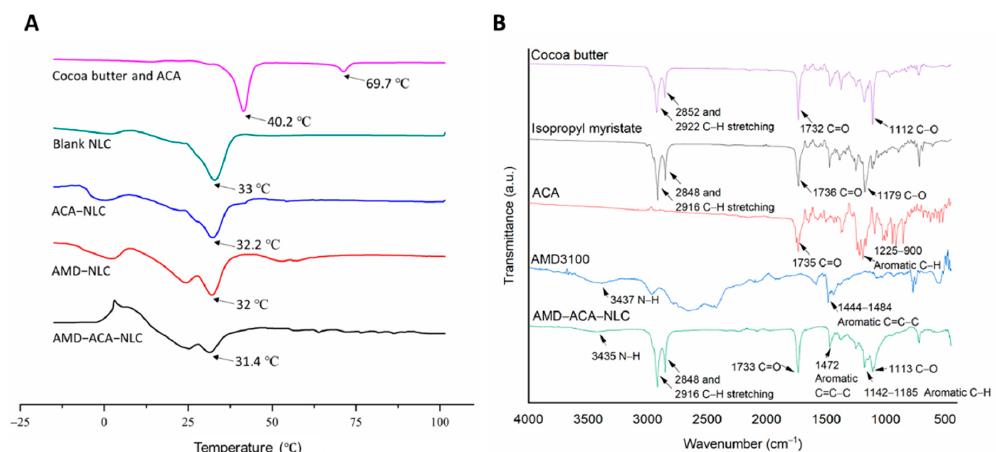
Figure 2. Differential Scanning Calorimetry (DSC) thermograms and Fourier-Transform Infrared Spectroscopy (FTIR) spectrum of samples. ( A ) Thermograms of cocoa butter–ACA physical melt, blank NLC, ACA-NLC, AMD-NLC, and AMD-ACA-NLC. The arrows point to the peak melting temperatures observed in each sample. ( B ) FTIR spectrum of cocoa butter, isopropyl myristate, ACA, AMD3100, and AMD-ACA-NLC. The arrows point to the characteristic peaks of each sample.